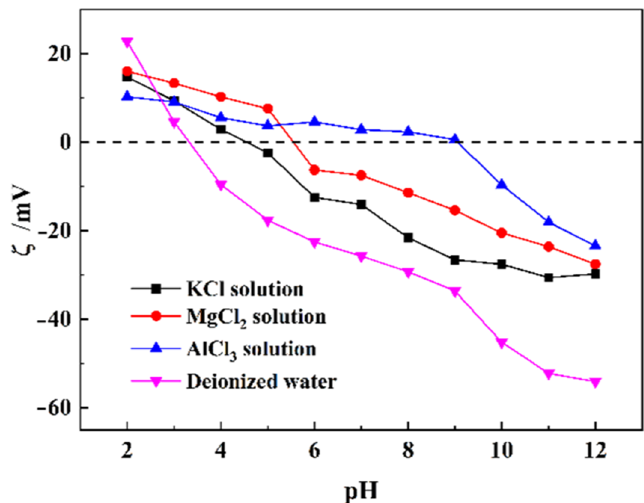
Figure 6. The effect of different inorganic salts on the zeta potential of graphite.